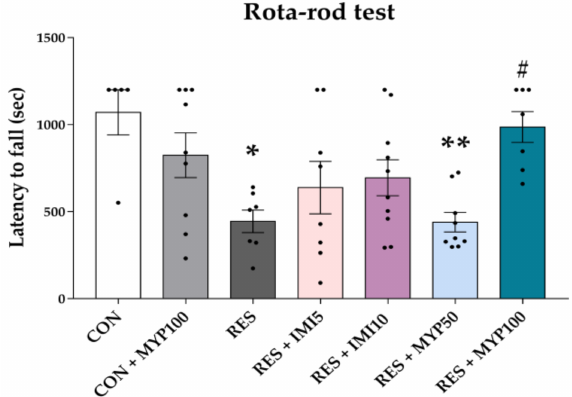
Figure 4. Improvement effect of myelophil (MYP) treatment on fatigue behavior. Rota-rod tests were performed to analyze the fatigue behavior on day 22. The latency time to fall from the rod significantly increased after treatment with 100 mg/kg of MYP. CON: control ( n = 5), CON + MYP100: 100 mg/kg MYP treatment ( n = 9), RES: 2 mg/kg reserpine treatment ( n = 7), RES + IMI5: 2 mg/kg reserpine and 5 mg/kg imipramine treatment ( n = 8), RES + IMI10: 2 mg/kg reserpine and 10 mg/kg imipramine treatment ( n = 10), RES + MYP50: 2 mg/kg reserpine and 50 mg/kg MYP treatment ( n = 9), RES + MYP100: 2 mg/kg reserpine and 100 mg/kg MYP treatment ( n = 7). Data are expressed as the mean ± SEM. One-way ANOVA with Tukey post hoc tests was executed. * p < 0.05, ** p < 0.01 vs. CON; # p < 0.05 vs.